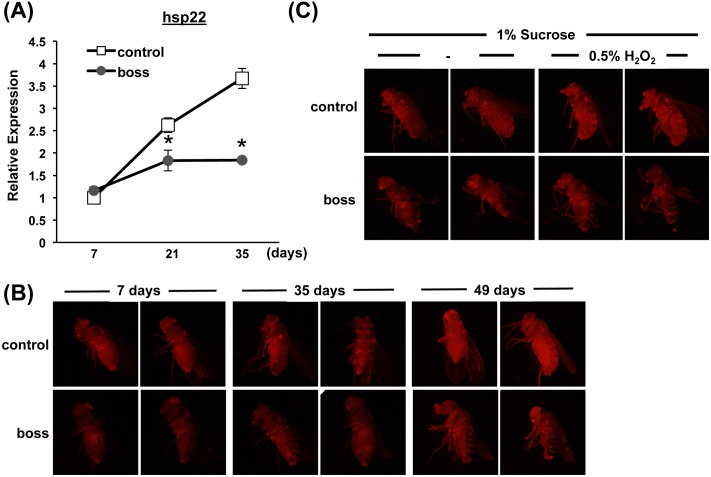
hsp22 expression is not induced in boss mutant flies.(A) Expression of hsp22 mRNA was measured in 7-, 21-and 35-days-old control and boss mutant flies by using qRT-PCR (n = 3, 10 flies per replicate). Data are means ± SEM (t-test, *P<0.05). (B) DsRed fluorescence was observed in control and boss mutant flies bearing the Hsp22-DsRed reporter. DsRed fluorescence progressively increased during aging in control but not in boss mutant flies. (C) Flies bearing the Hsp22-DsRed reporter were transferred to a diet containing 0.5% H2O2 for 24 h, and then DsRed fluorescence was observed. Under this oxidative stressful condition, boss mutant flies still failed to exhibit increased hsp22 expression, suggesting dysfunctional mitochondria and oxidative stress dysregulation.